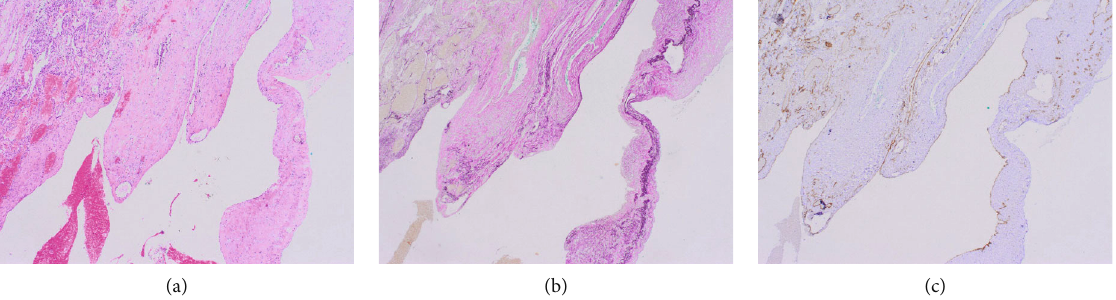
Figure 3: Microscopic appearance of mass removed from the lung of the patient at 25 +4 weeks of pregnancy presented with dyspnea on multiple occasions from 20 weeks of pregnancy. (a) Hematoxylin-eosin staining, original magni fi cation × 10; (b) ERG staining, original magni fi cation × 10; (c) CD34 staining, original magni fi cation × 10.